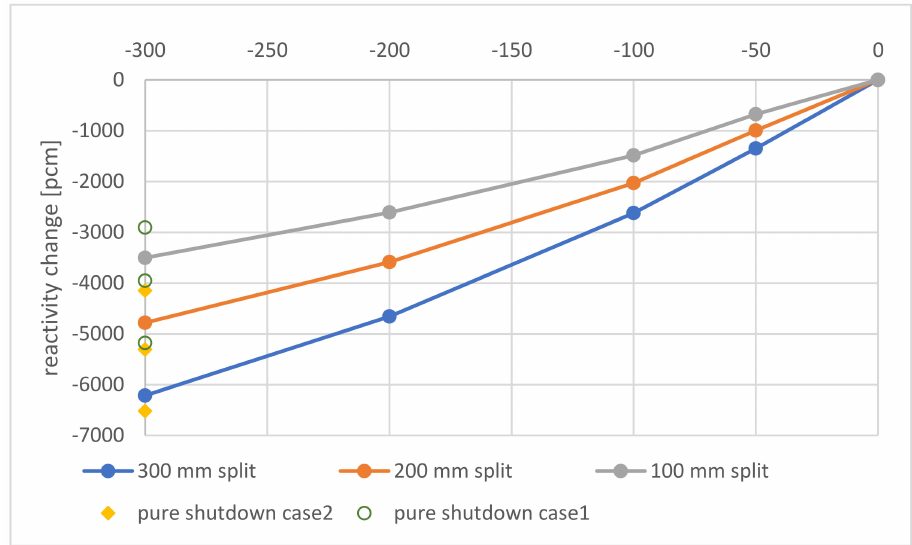
Figure 14. Shutdown reactivity from critical system dependent on the opening width of the shutdown system based on the 30 cm case with 140 cm diameter and 140 cm height.